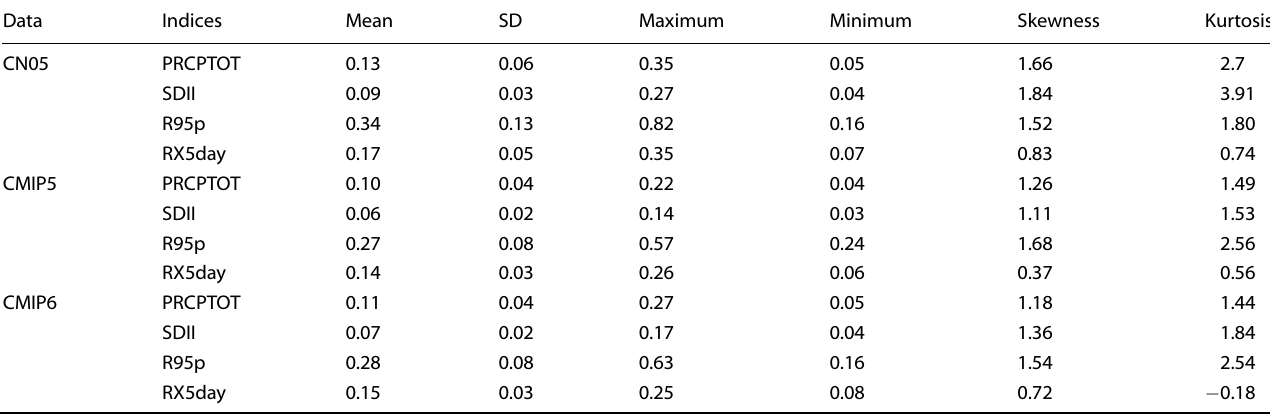
Table 1. Univariate statistics of the Gini-coef fi cient of the observed and historical simulated precipitation extreme indices from 1961 to 2005. Data Indices Mean